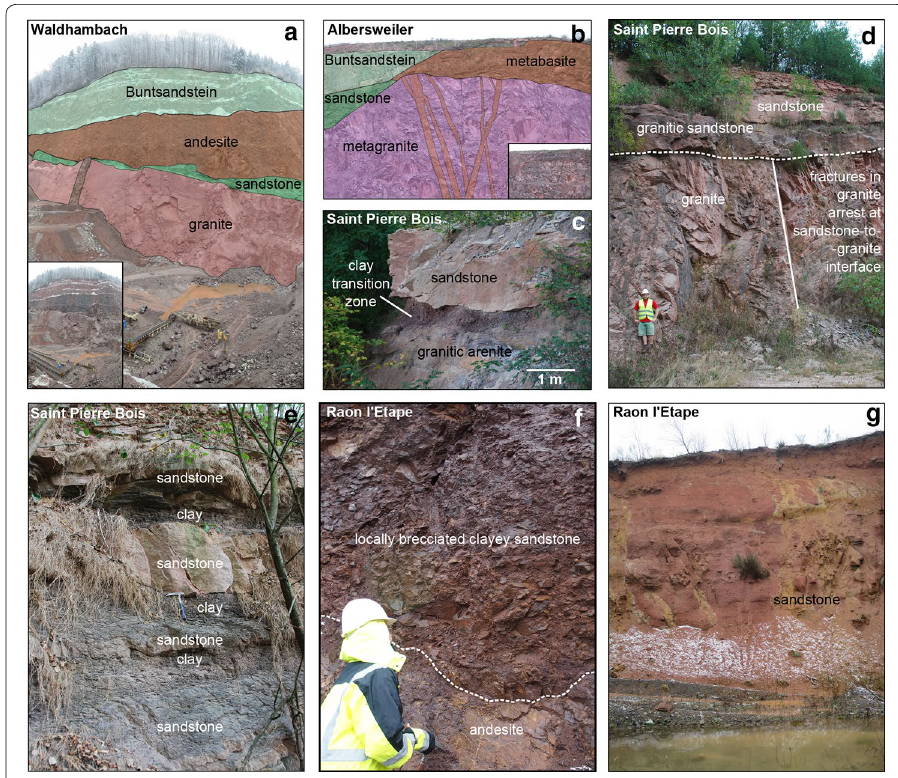
Fig. 2 Photos of the field locations from which the rock samples were taken. The dominant lithologies at each site are indicated. a Waldhambach, Germany. b Albersweiler, Germany. c Saint Pierre Bois, France. d Saint Pierre Bois, France. Note the fractures present in the granite become arrested at the sandstone–granite interface. e Saint Pierre Bois, France. Note the alternating sandstone and clay units. f Raon l’Etape, France.